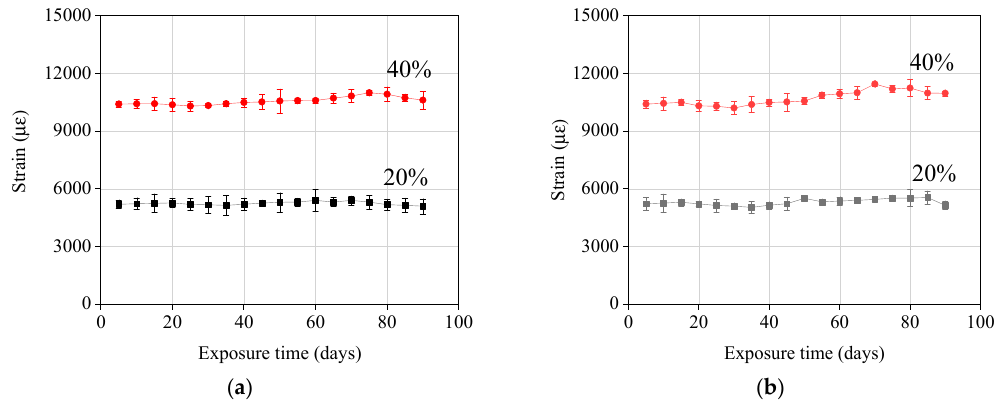
Figure 8. Change in axial strain in GFRP bars over time under different stress levels: ( a ) Exposure to seawater solutions and ( b ) exposure to concrete pore solutions.